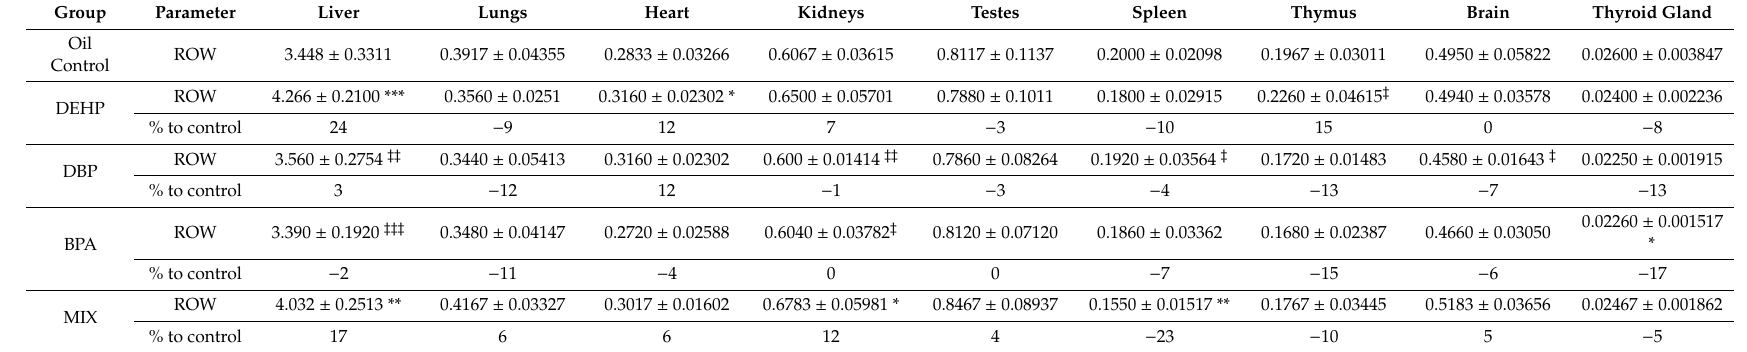
Table 4. Relative organ weights (ROW) of rats orally exposed to DEHP, DBP, BPA, and their mixture (MIX) for 28